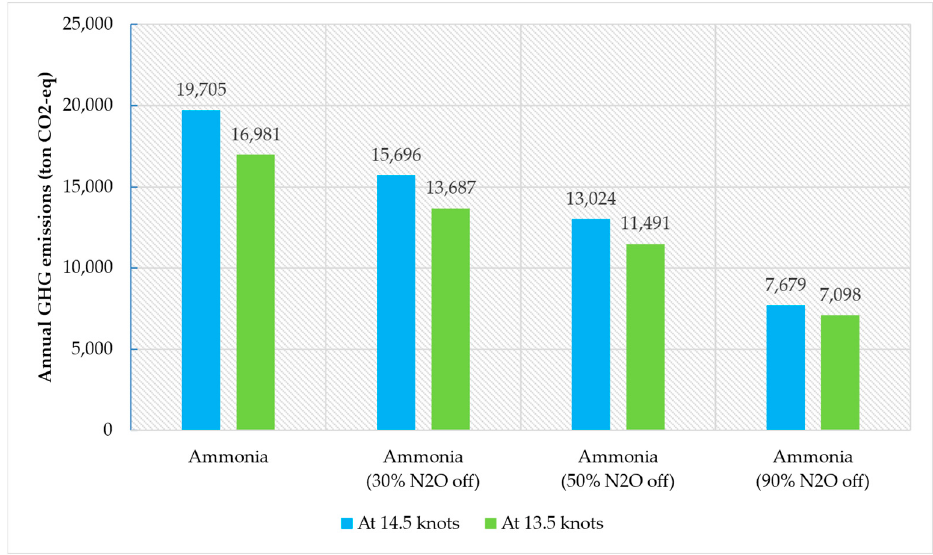
Figure 8. Annual TTW GHG emissions of using ammonia considering N 2 O abatements.